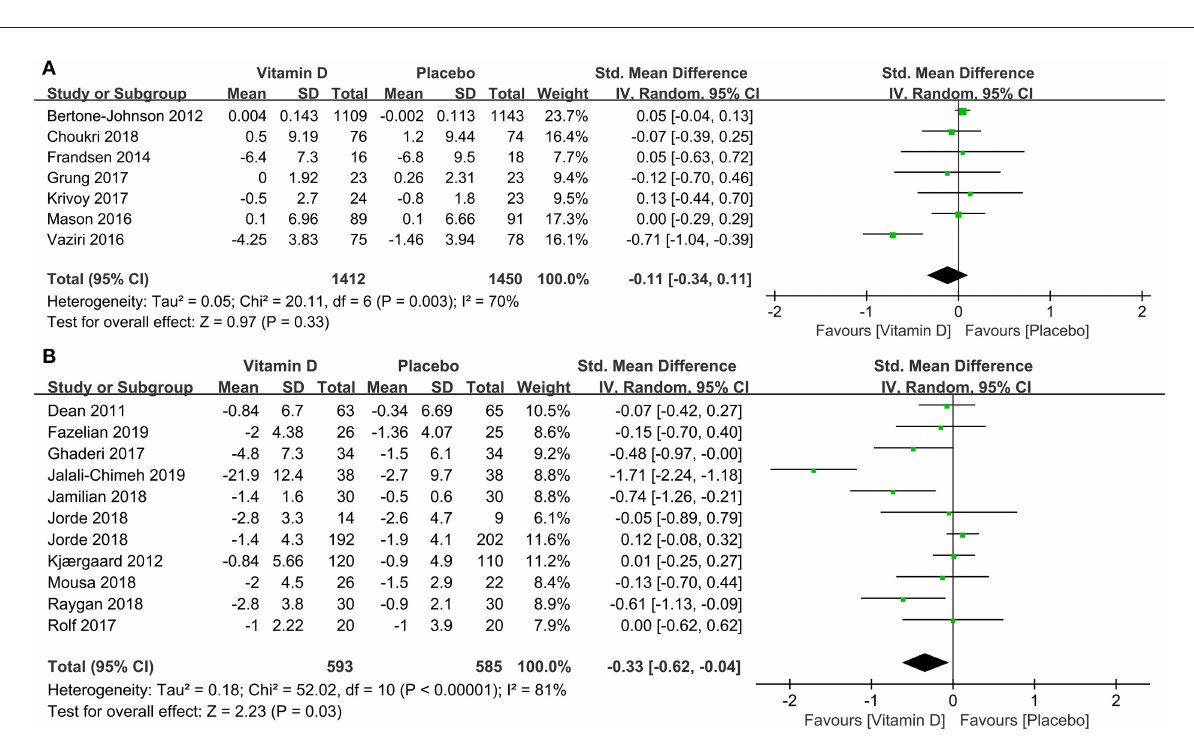
at baseline between the two groups. The results illustrated that compared to the control group, those with depression and low serum vitamin D levels might benefit from vitamin D supplementation (SMD: − 1.10) (Figure 6). The correlation between vitamin D usage and the development of depression among low doses ( ≤ 2,800 IU/day) and high